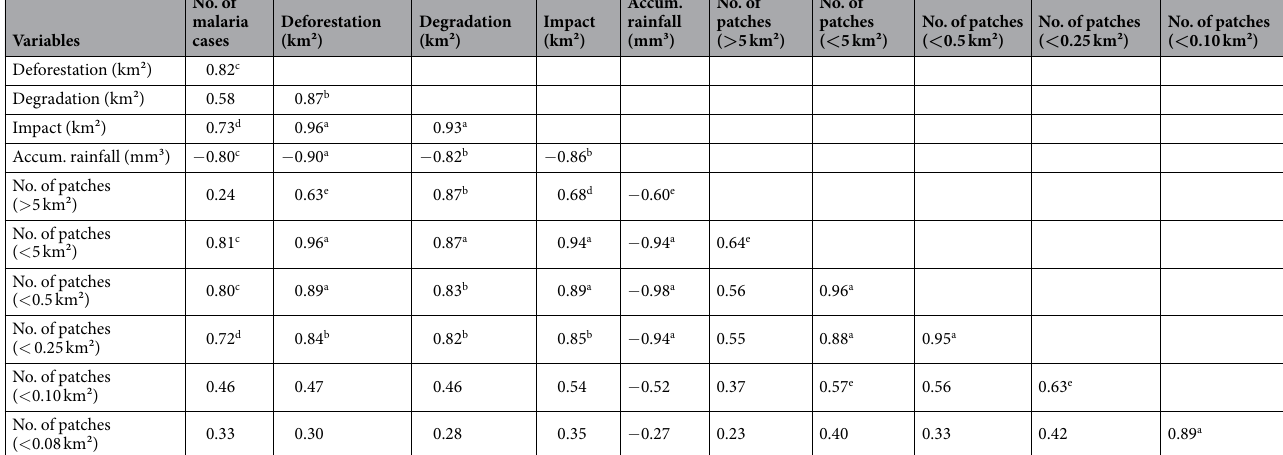
Table 1. Matrix of the correlation between the variables of deforestation activities, landscape and